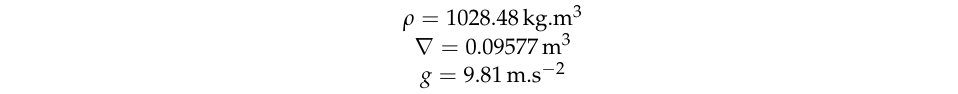
Table 4. The underwater vehicles’ parameters.